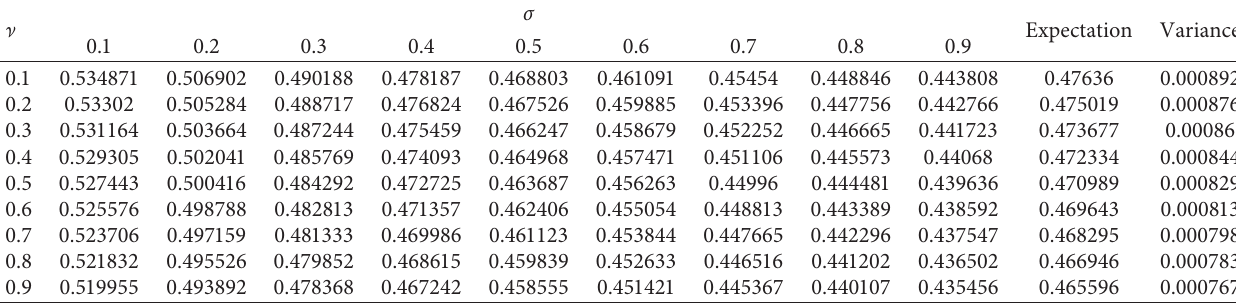
Table 3: Sensitivity analysis of the influence of ] and σ on λ ∗